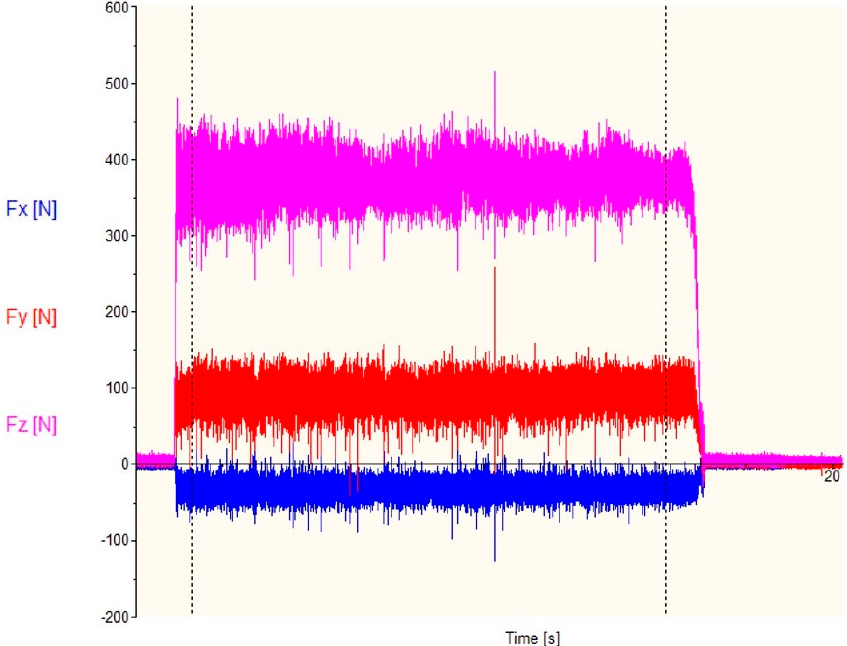
Figure 14. Cutting forces during turning by tool with new cutting insert with parameters: ap = 2 mm, f = 0.1 mm/rev.